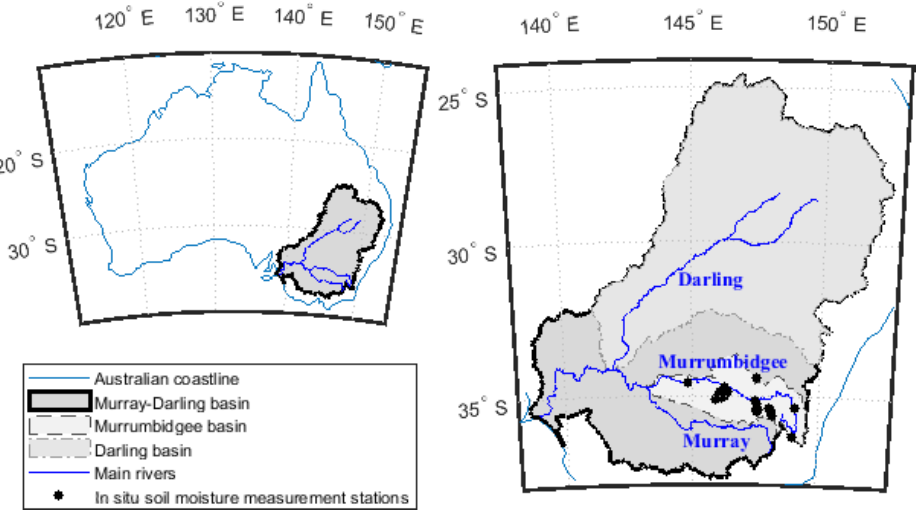
Figure 1. Study area: the Murray–Darling, Murray, Darling and Murrumbidgee basins, river stream courses and in situ soil moisture mea- surement